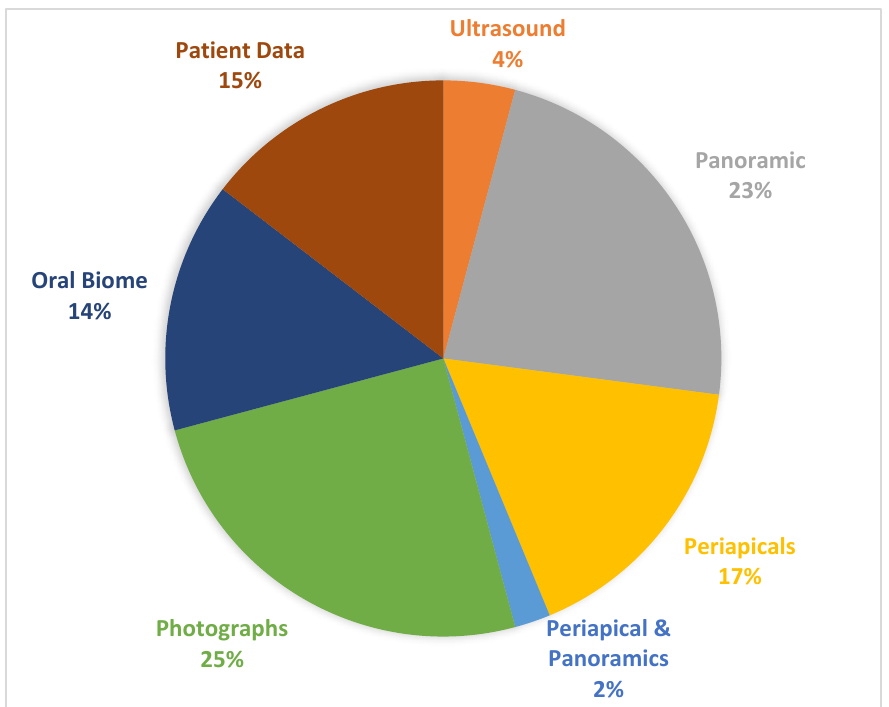
Figure 5. Input data.